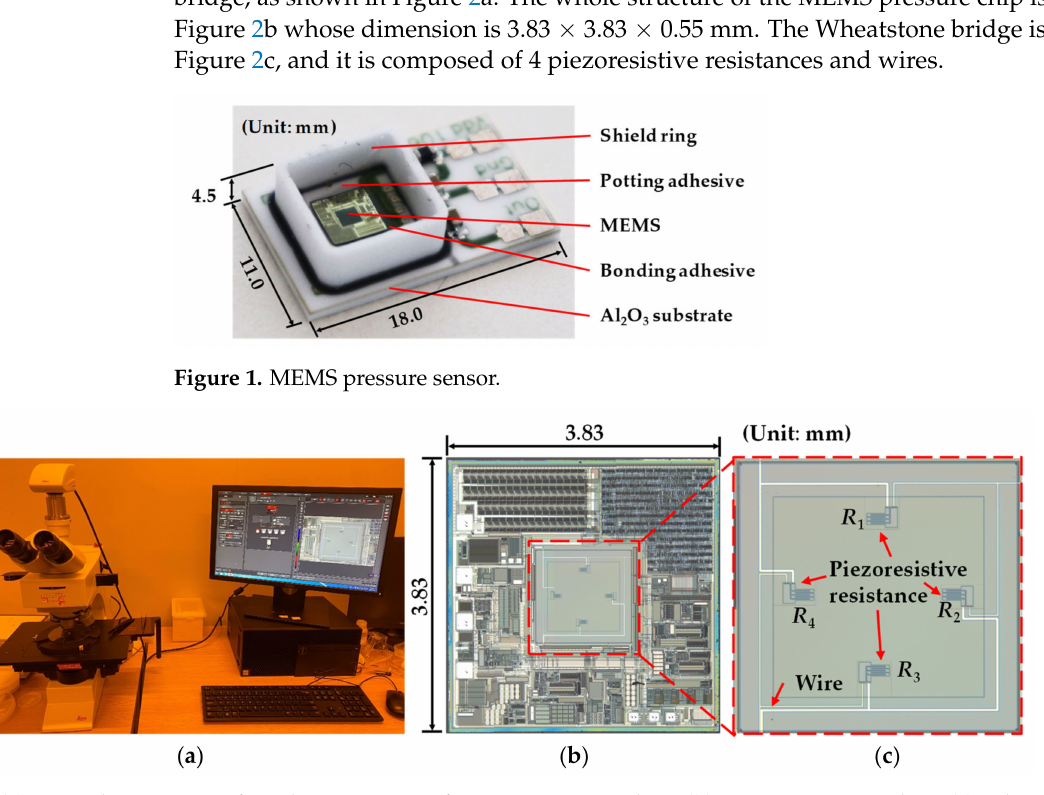
Figure 2. ( a ) Optical microscope for taking pictures of MEMS pressure chip. ( b ) MEMS pressure chip. ( c ) Wheatstone bridge.